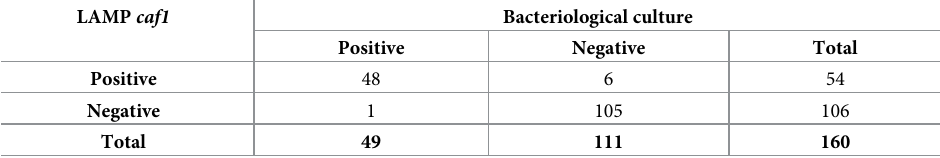
Table 3. Evaluation of LAMP caf1